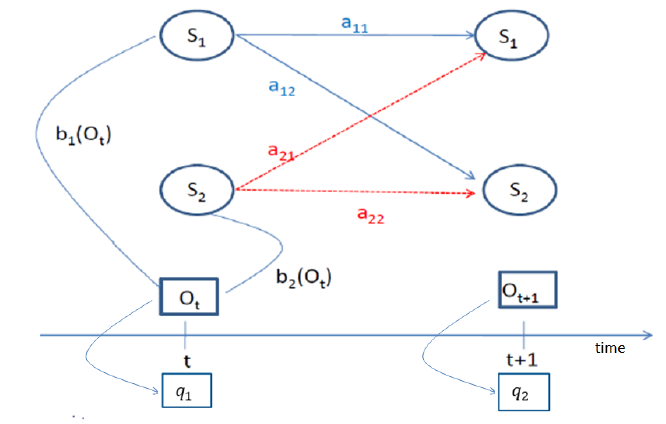
Figure 1. Hidden Markov model (HMM) with two states.